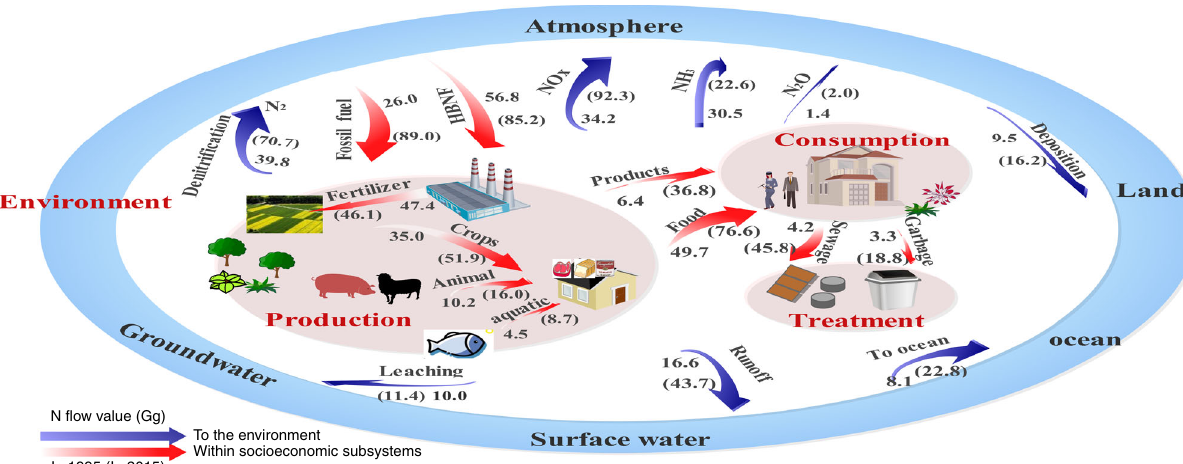
Fig. 1 Coupled human-natural urban nitrogen fl ow analysis in Guangzhou from 1995 to 2015. N fl ows among production, consumption, treatment and environment process groups under anthropogenic perturbations. The numbers in brackets and out of brackets represent N fl uxes in 2015 and 1995, respectively. HBNF, Haber- Bosch N fi xation. Units are in Gg N y −